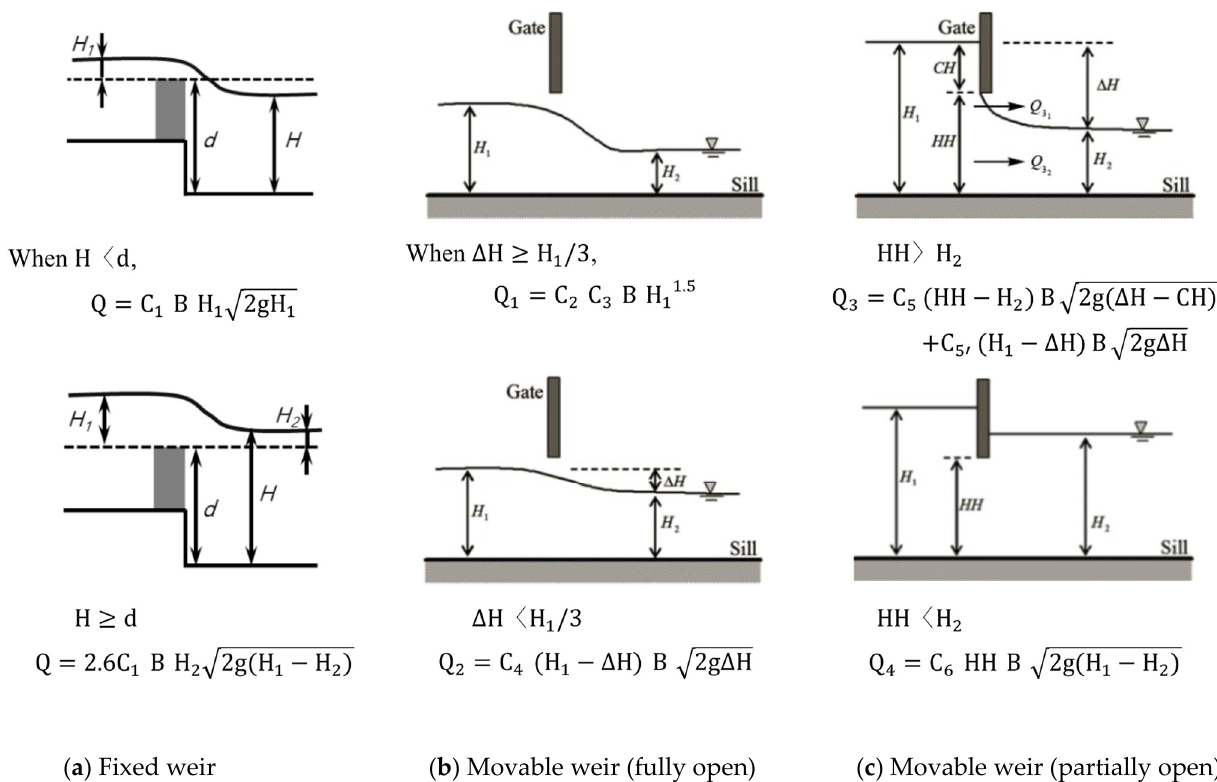
Figure 2. Schematic and flow equations for ( a ) fixed weir; ( b , c ) movable weir operations. C 1 –C 6 are the coefficients of discharge and B is the width of the weir.